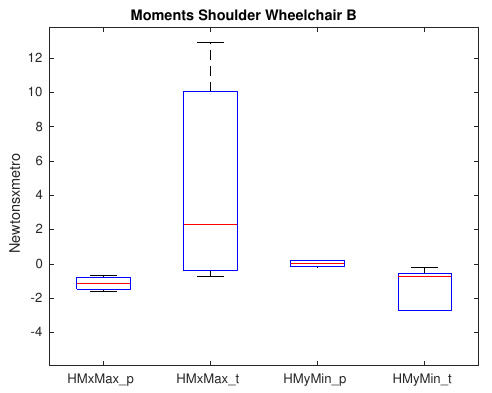
Figure 6. Moments that show significance on the shoulder between paraplegics and tetraplegics when propelling wheelchair B. HMxMax shows the maximum adduction moment on the shoulder and HMyMin shows the minimum extension moment on the shoulder. In all cases, the values for paraplegics (_p) and tetraplegics (_t) are shown.